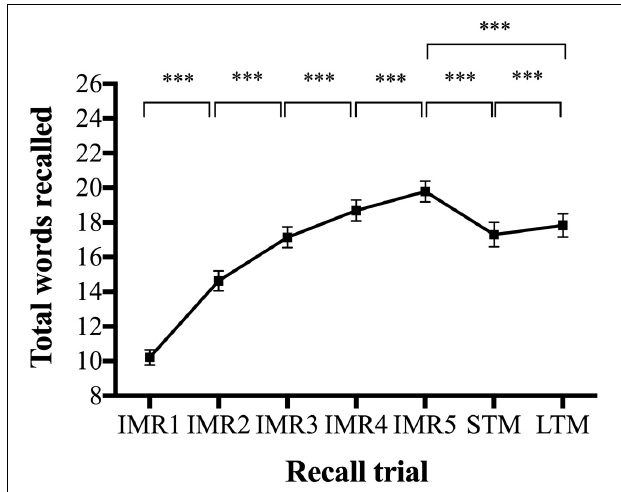
FIGURE 2 | Recall curves for the Verbal Affective Memory Test-26 (VAMT-26). *** p < 0.0001. Recall means and confidence intervals (CI) for each of the seven trials in VAMT-26. Parametric tests were used to calculate the CI displayed in the figure. IMR1–5, immediate recall trials 1–5; STM, short-term memory; LTM, long-term memory. P -values in analyses on learning effects (i.e., change in total recall of words between each IMR list presentation) were obtained using Wilcoxon sign-rank tests and adjusted for four comparisons using the Bonferroni–Holm adjustment procedure (Holm, 1979). P -values in analyses on differences in recall between IMR5 vs. STM, IMR5 vs. LTM trials, STM vs. LTM were obtained using three Wilcoxon sign-rank tests and adjusted for three comparisons using the Bonferroni–Holm adjustment procedure (Holm,